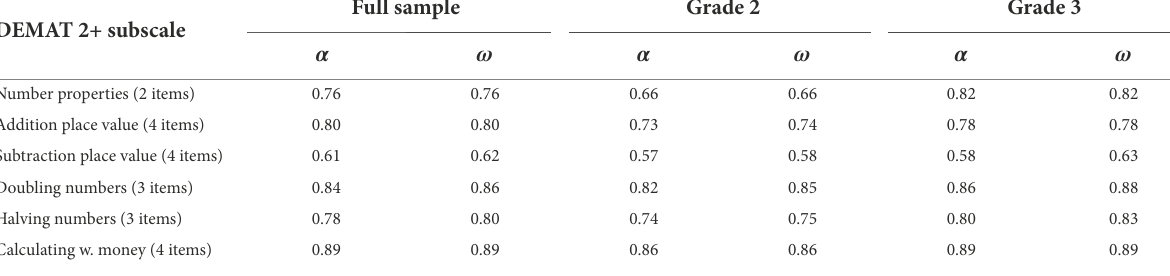
TABLE 6 Cronbach’s Alpha and Mc Donald’s Omega coefficients at last measurement time point.